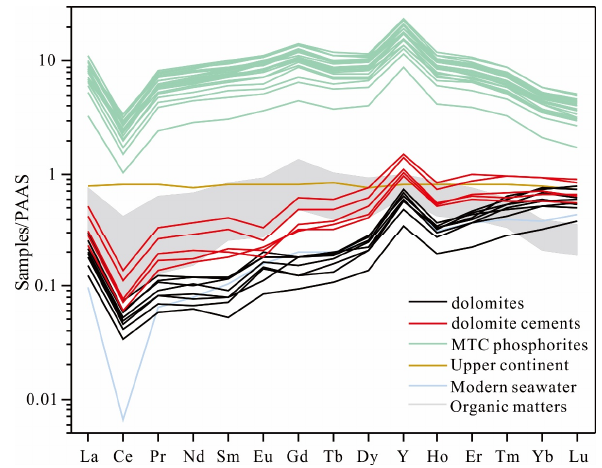
Figure 8. Post-Archean Australian shale (PAAS)-normalized REY patterns of the Zhijin phosphorites and dolomites. Upper continental crust data were obtained from [27]. Organic matters from Niutitang formation data were obtained from [40]. The REY data of modern seawater is magnified 10 6 times [76].